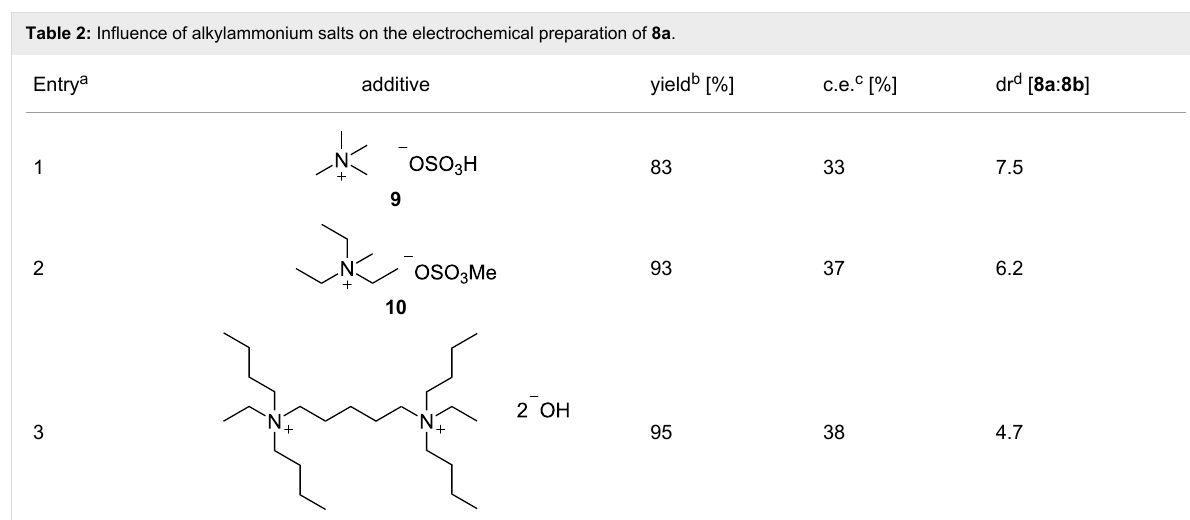
Table 2: Influence of alkylammonium salts on the electrochemical preparation of 8a . Entry a additive yield b [%] c.e. c [%] dr d [ 8a : 8b ]